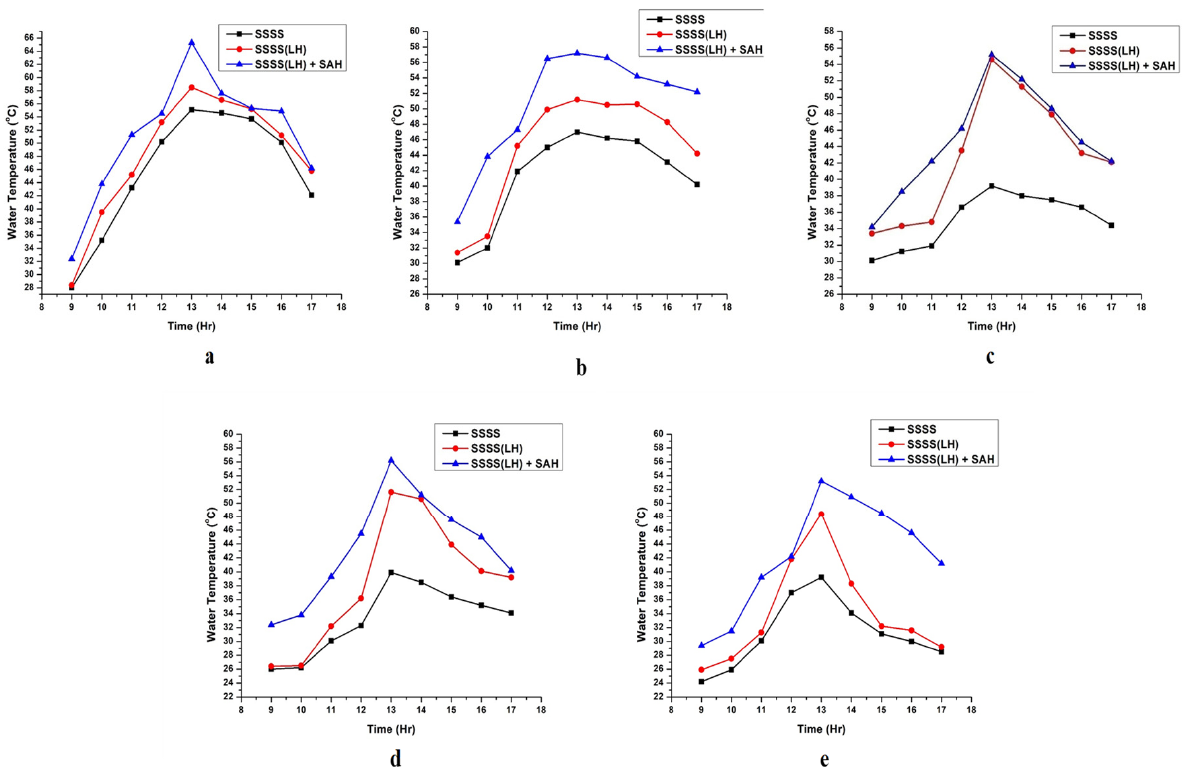
Figure 4. ( a – e ) Variation of water temperature vs. time at the depth of 3 cm, 6 cm, 9 cm, 12 cm and 15 cm, respectively. 15 cm, respectively.